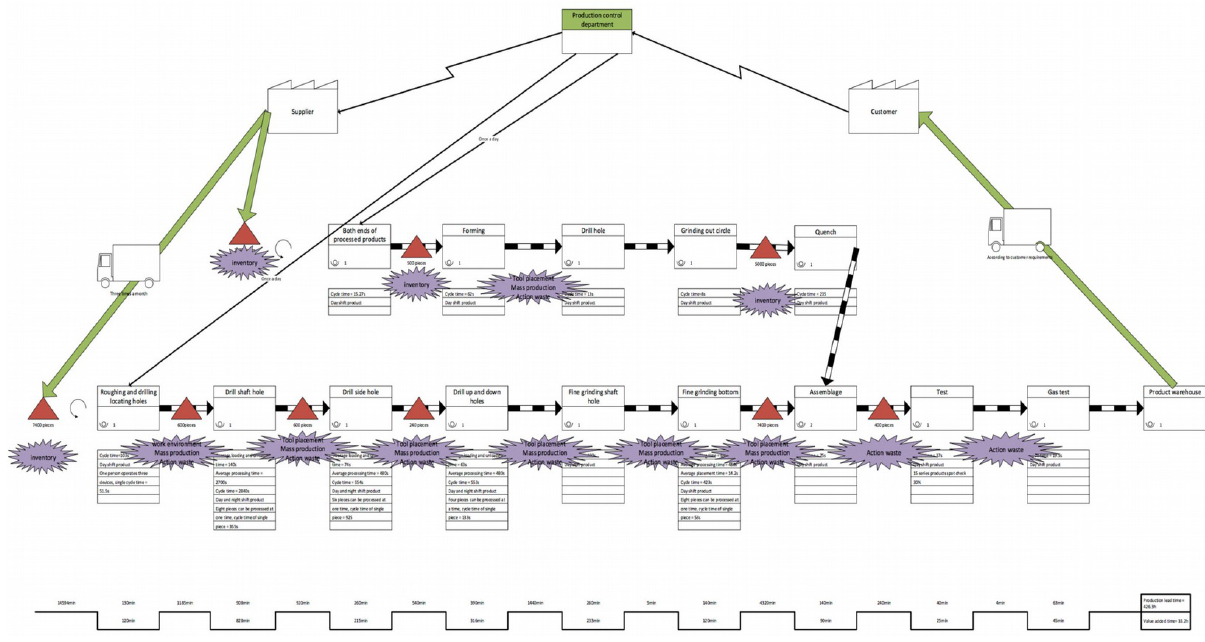
Figure 3. Current value stream of product family A